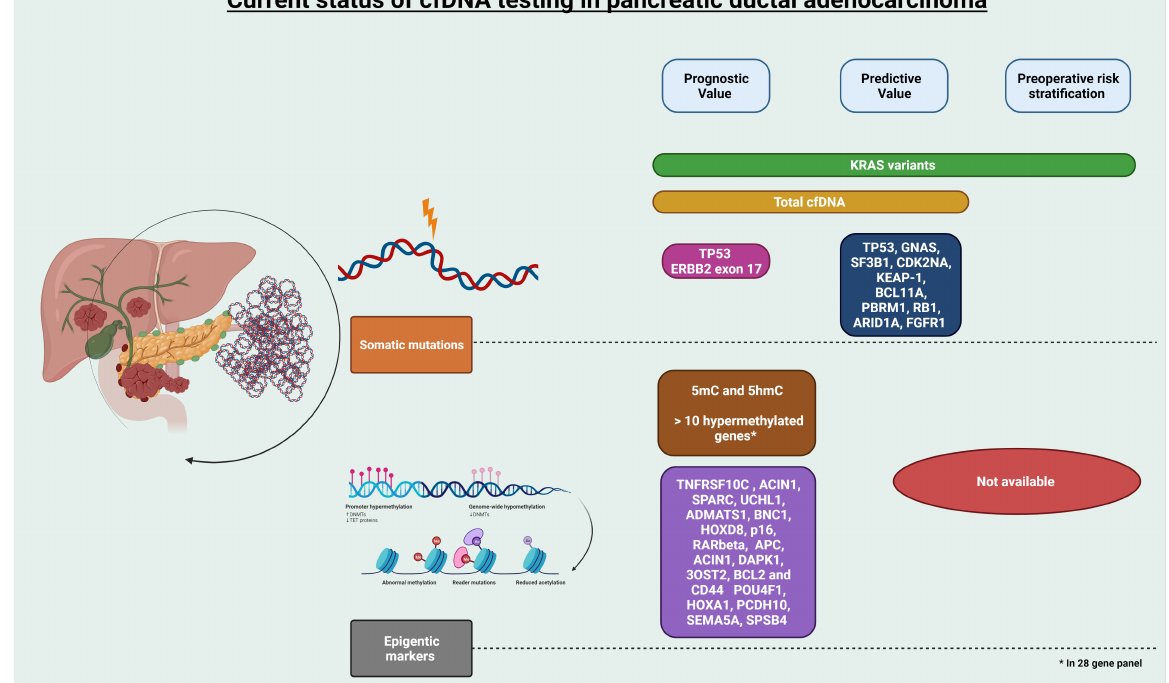
Figure 1. cfDNA somatic mutations and epigenetic markers in pancreatic ductal adenocarcinoma. Summary of specific somatic mutations and epigenetic markers that can be detected in cfDNA which have been shown to confer prognostic, predicative, and preoperative risk stratification value in patients with pancreatic ductal